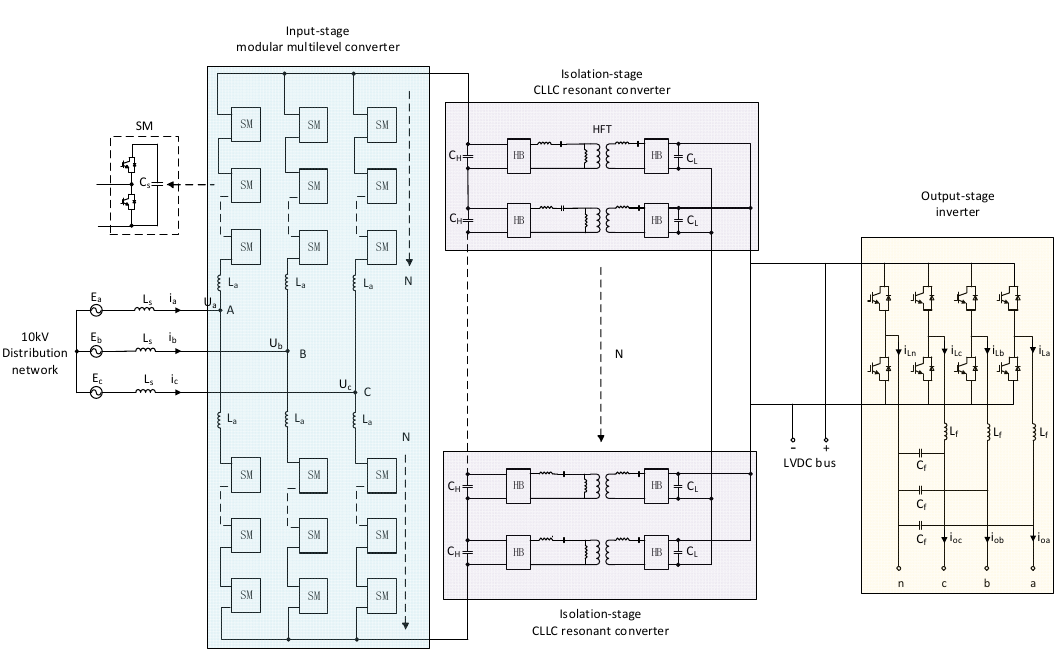
Figure 2. Topology of the solid state transformer (SST).